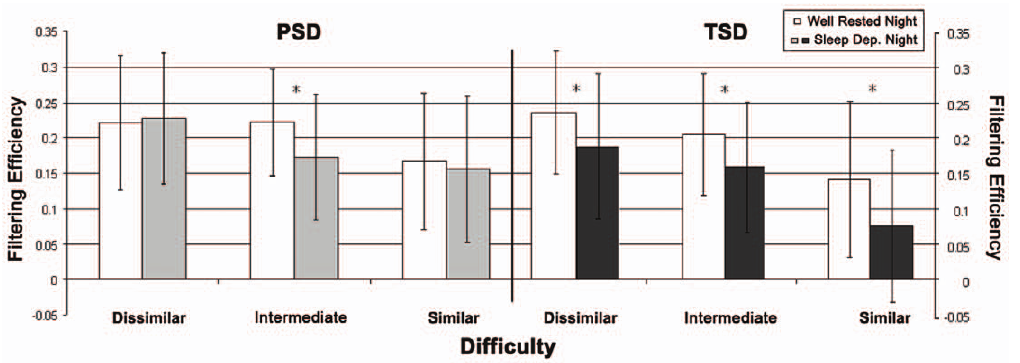
Figure 4. Filtering Efficiency. Filtering efficiency values are shown for both Groups, both Nights, and all 3 levels of Difficulty. Values are mean 6 standard deviation. *=p # .05 for the simple main effect of Night.